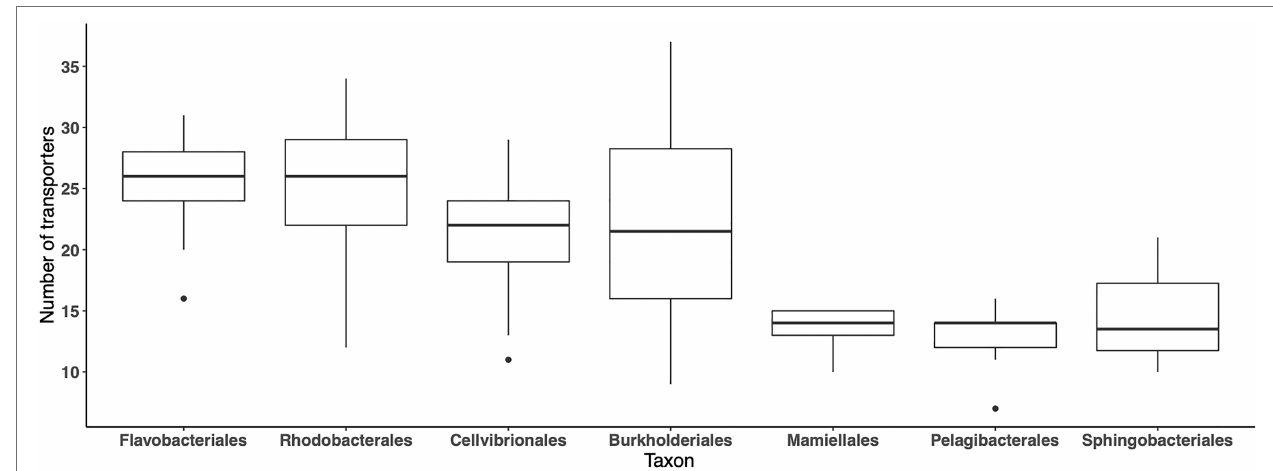
FIGURE 5 | Number of different transport protein clusters for each of the seven most abundant orders, across the LMO 2012 metagenome dataset. For each order, the value at a specific sample point is only shown if the sum of normalized transporter abundance for that order was greater or equal to the 90% quantile calculated for all orders in the